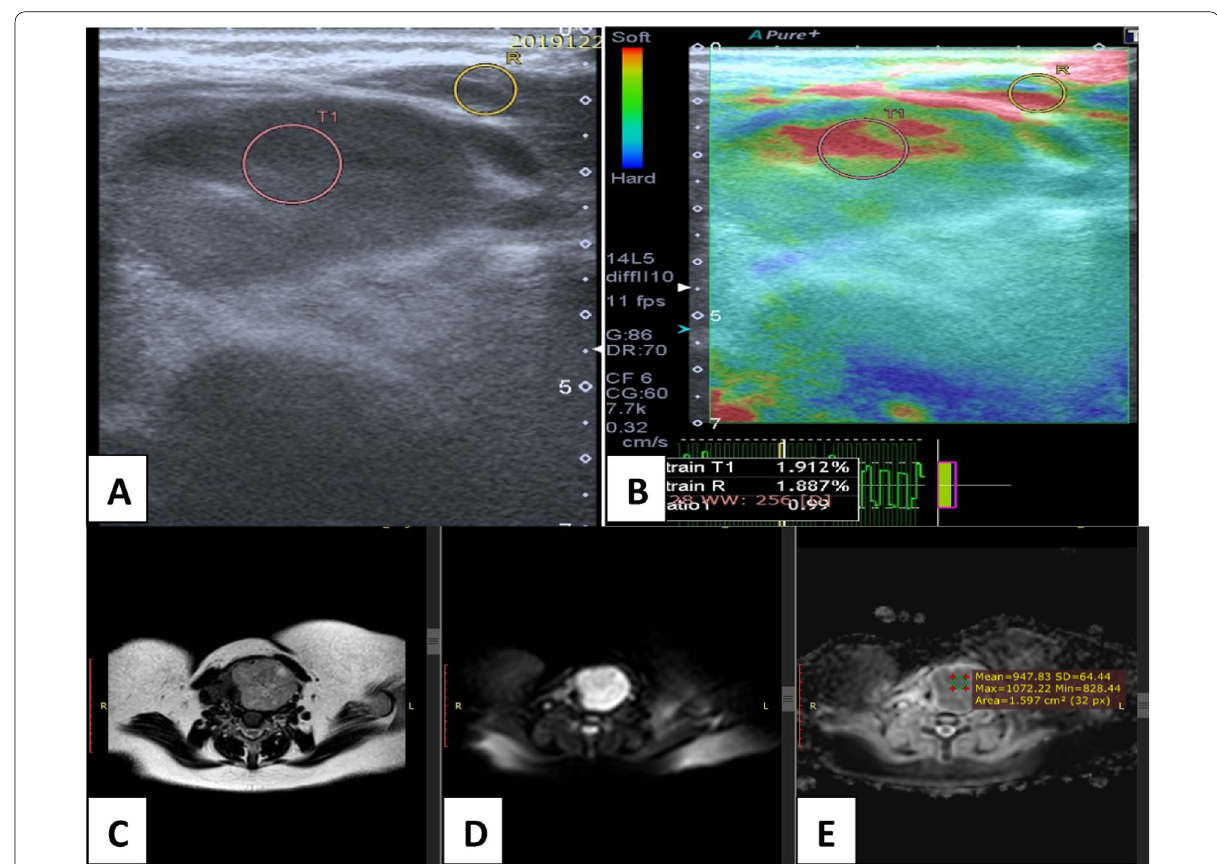
Fig. 4 Female patient aged 26 years presented with left lobe nodule. Ultrasound features of the nodule A : The left lobe shows solid hypoechoic nodule, wider more than taller with well-defined outline. No calcifications were noted. TIRADS categorization: TIRADS (4). On elastography color map B : most of the nodule is shaded with red and green (centrally) with small peripheral blue areas. Elastography score: (2) Strain ratio study: T2 weighted image C : left lobe nodule with intermediate signal intensity is seen. Diffusion weighted images D : the nodule shows high signal intensity. ADC mapping E : it shows low signal with ADC value 0.94 10 − 3 . Pathology: follicular thyroid = ×